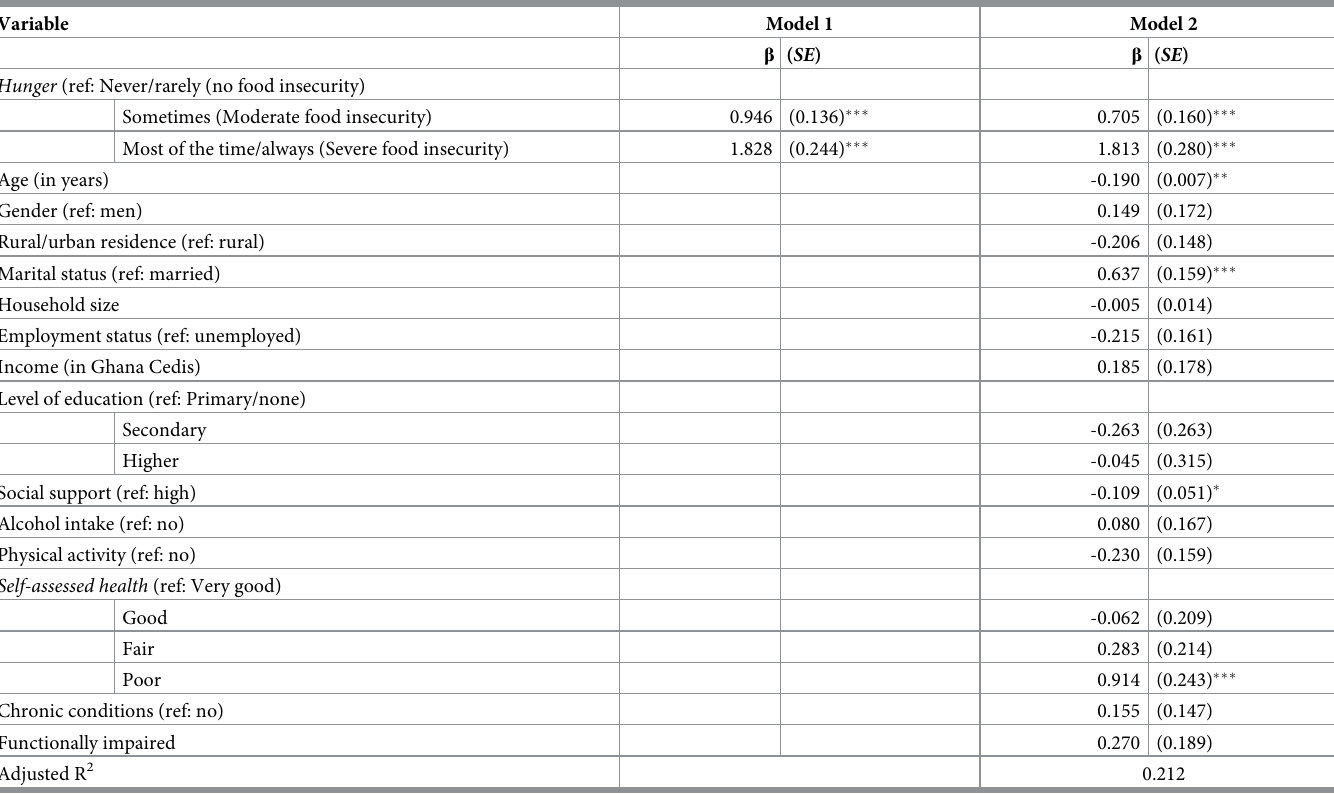
Table 2. The associations between food insecurity with hunger and psychological distress score (10–50): Multivariate pooled linear analysis.